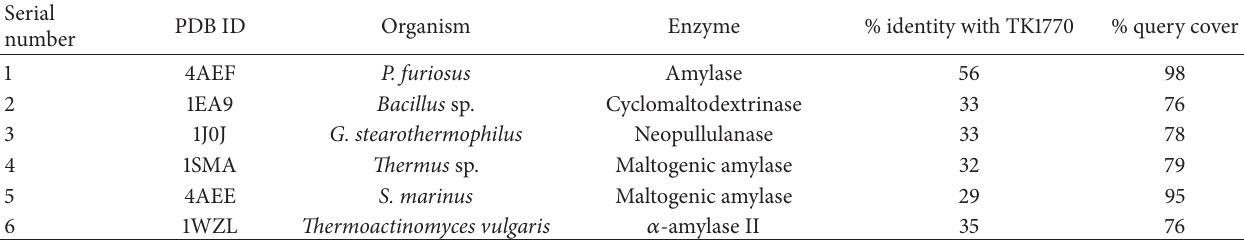
Table 2: List of the PDB files used as templates for homology modeling of CDase